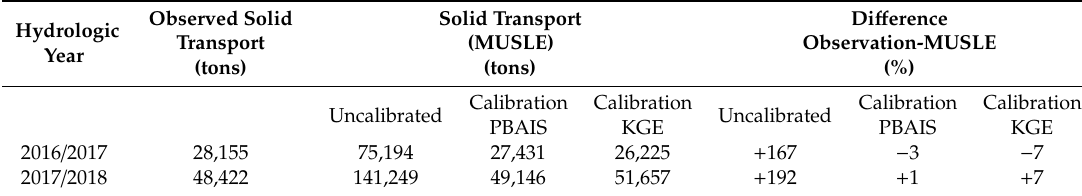
Table 16. Results of the MUSLE model at Sidi Mohamed Cherif on the Machraa and comparison with observations.